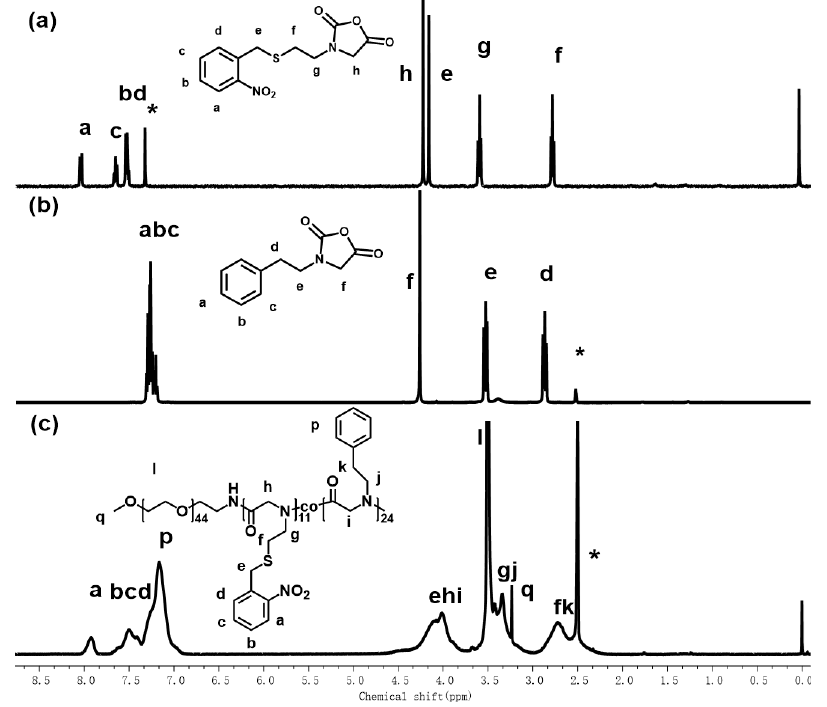
Figure 1. 1 H NMR spectra of ( a ) NSN–NCA in CDCl 3 , ( b ) NPE–NCA and ( c ) PEG- b -PNSN- co -PNPE in DMSO. * indicates